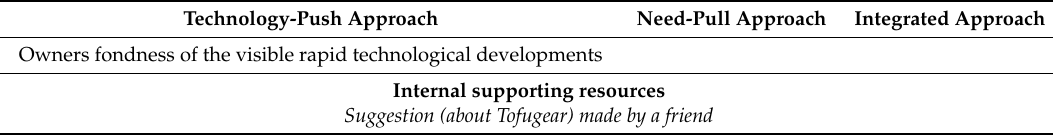
Table 7. Summary of the adoption drivers for House of Blue